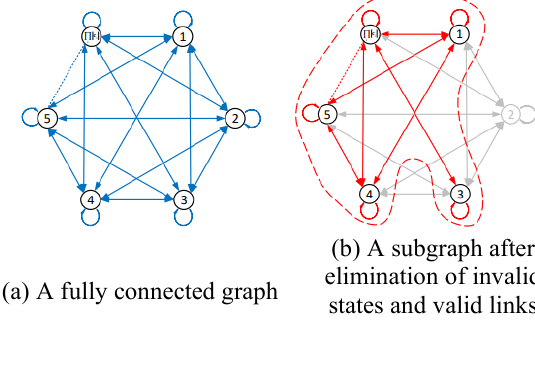
Figure. 2 All possible switch pairs model